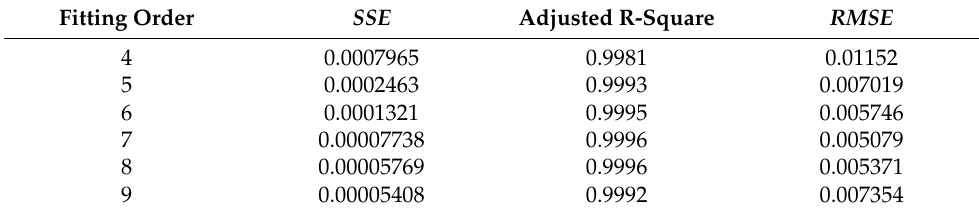
Table 3. Comparison of the goodness of fit of the SoC-OCV curve.